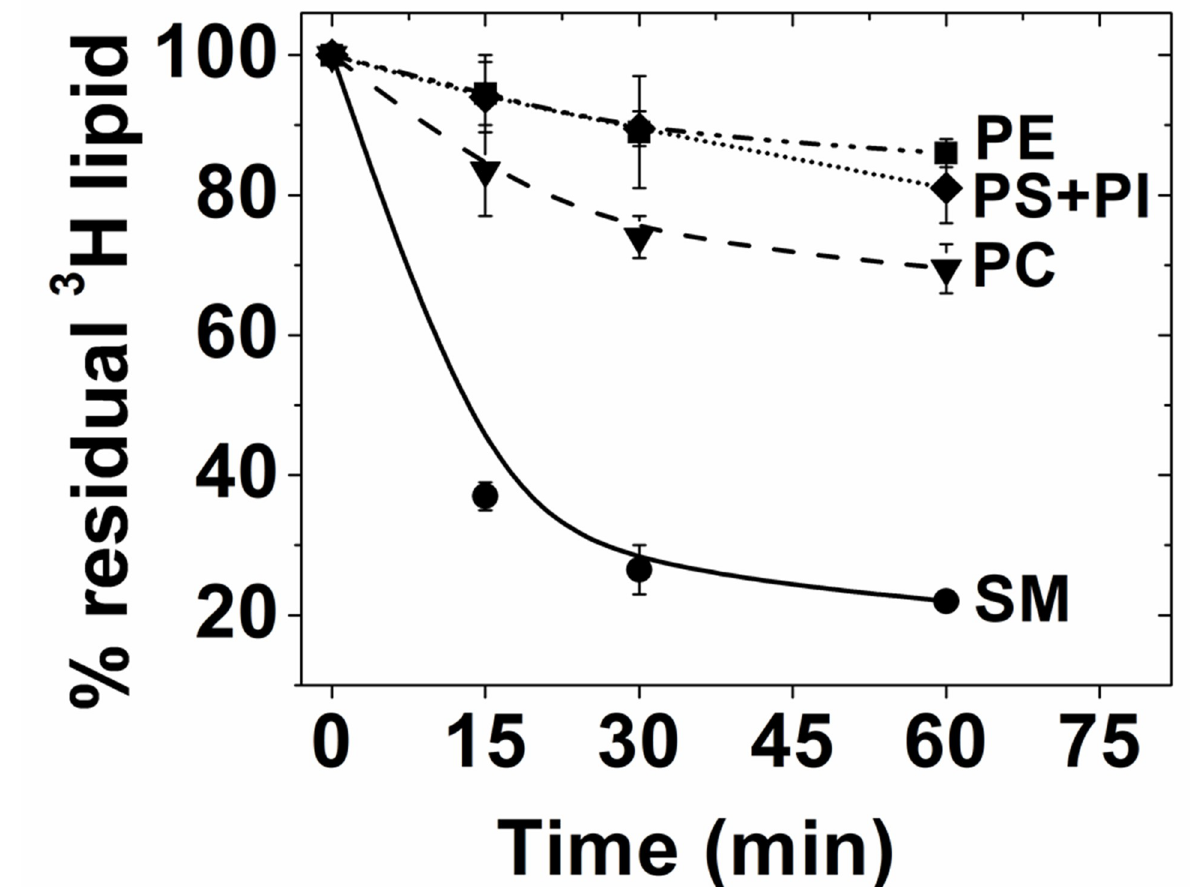
Fig 9. Time-course of endogenous lipid exchange out of 3 H labeled CHO cells. Endogenous 3 H lipids analyzed by measuring radioactivity in lipid TLC bands from a total lipid extract (for details see Materials and Methods). The residual % 3 H lipid = [(cpm for a lipid after exchange)/(cpm for that lipid at time 0)] x 100% Exchange was carried out in 10 cm diameter plates at 37˚C with 2 ml of 2 mM eSM plus 50 mM M α CD. Mean and range from two experiments is shown.